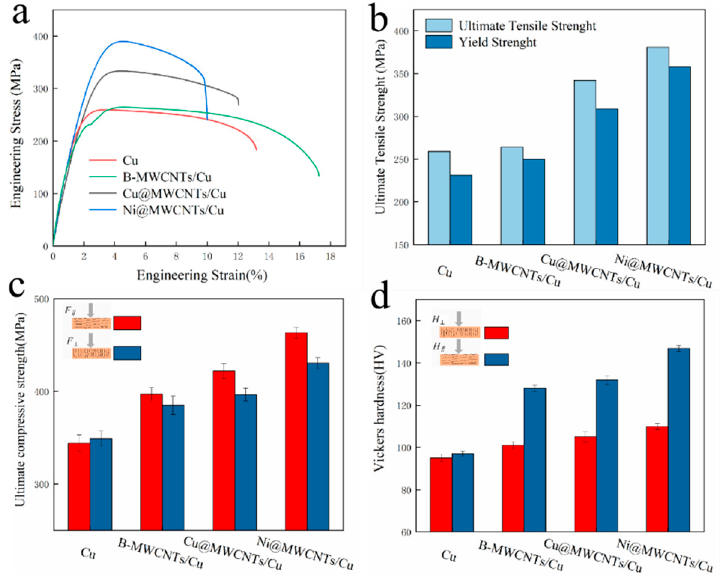
Figure 5. Mechanical properties of pure Cu and MWCNTs/Cu composites. ( a ) Stress-train curve, tensile test direction parallel to drawing direction. ( b ) UTS and YS. ( c ) Compressive strength. F ∥ : test surface was parallel to drawing direction. F ⊥ : test surface was perpendicular to drawing direction. ( d ) Vickers microhardness. H ∥ : test surface was parallel to drawing direction, H ⊥ : test surface was perpendicular to drawing direction.